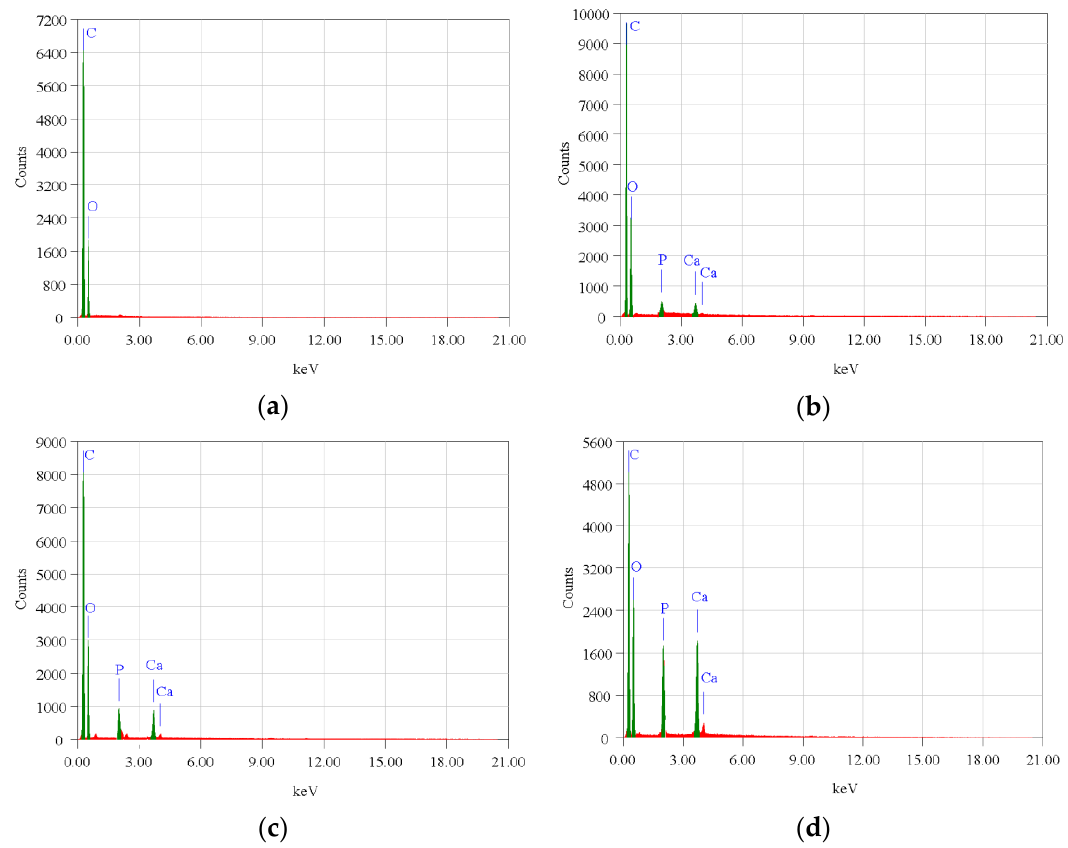
Figure 4. EDX profile of the PLA/PCL/nHA biocomposite specimens of ( a ) 0%; ( b ) 10%; ( c ) 20%; and ( d ) 30%.